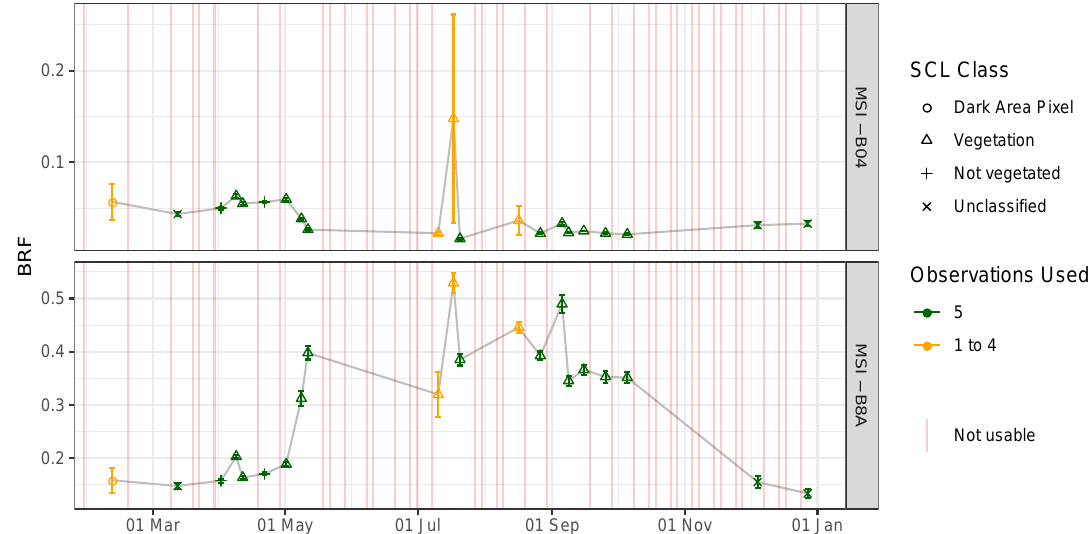
Figure 2. Observed BRFs for S2A MSI red and NIR band over the year 2016 for the five Speulderbos plots (see Figure 1). Points represent average BRF over the five plots, error bars one standard deviation. Colour codes the number of plots for which the observations were useful (clear sky). SCL class refers to the mode of all Scene Classification (SCL) given by sen2cor over the five plots. Observations used refers to how many of the BRF of the five plots were not affected by clouds and used for